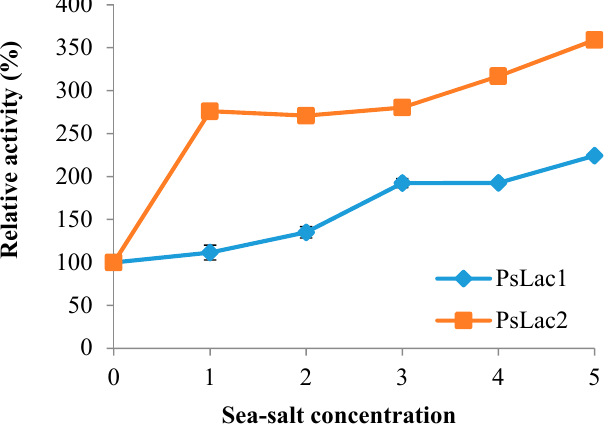
Figure 6. Effect of sea-salt addition (0 to 5% w / v ) on the activity of Ps Lac1 and Ps Lac2. Assays were performed using ABTS as substrate in standard conditions. Each data point (mean +/ − standard deviation) is the result of triplicate experiments.